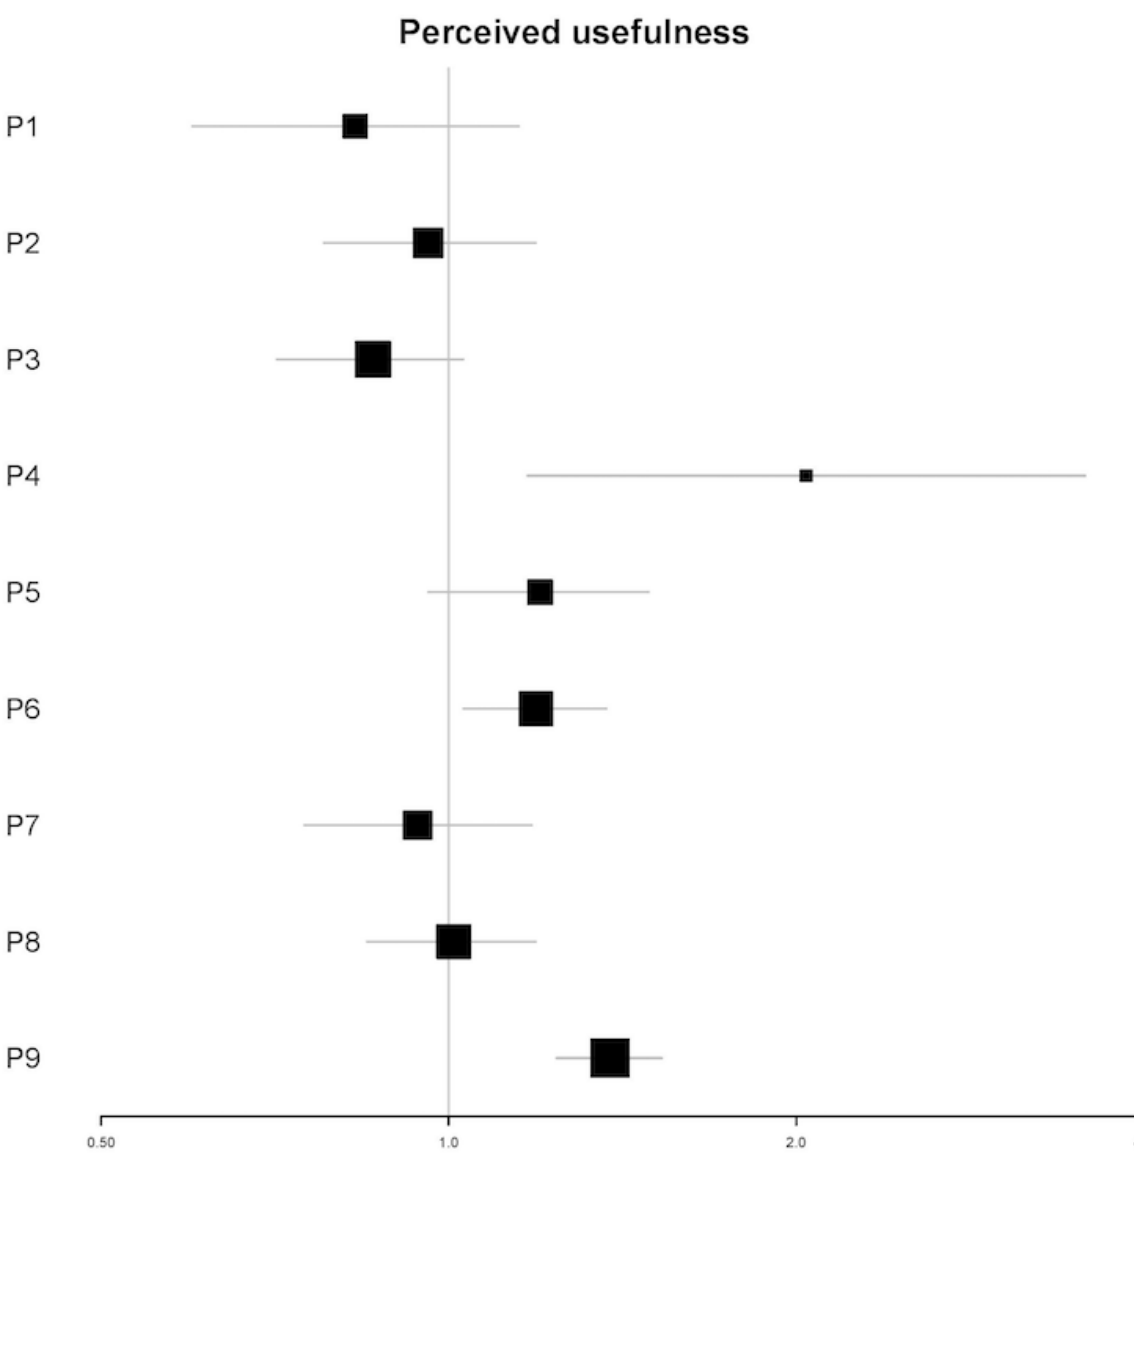
Figure 5. Plot of incidence rate ratios and 95% CIs (x-axis) for the association of perceived usefulness of the app and the frequency of engagement for each participant (y-axis) in univariable analyses. P: